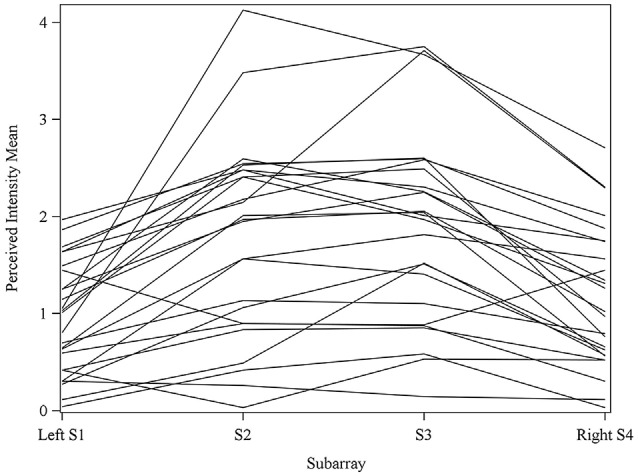
Perceived intensity profiles for all 25 subjects relative to Subarray across the tongue. Mean perceived intensities at each Subarray are indicated for each subject. Note that the profiles have a tendency to have large perceived intensity values in the middle of the tongue, regions stimulated by electrodes in Subarrays 2 and 3. In contrast, more lateral regions, stimulated by electrodes in Subarrays 1 and 4, have lower perceived intensities.